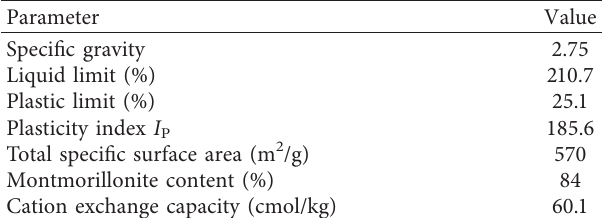
Table 1: Basic physical and chemical indices of tested